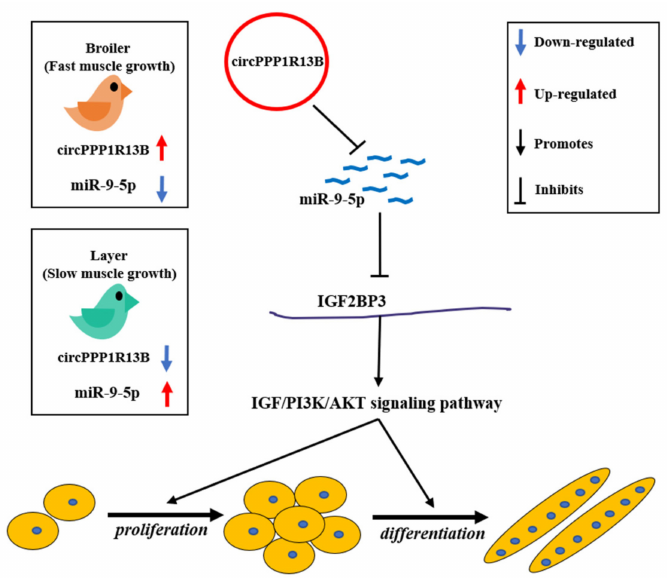
Figure 6. A schematic model of circPPP1R13B regulates chicken SMSC proliferation and differen- tiation. CircPPP1R13B highly expressed in the breast muscle of FMGB compared to that in SMGL, whereas miR-9-5p highly expressed in the breast muscle of SMGL compared to FMGB. Furthermore, circPPP1R13B promotes chicken SMSC proliferation and differentiation via targets miR-9-5p to active IGF2BP3 mediated IGF/PI3K/AKT signaling